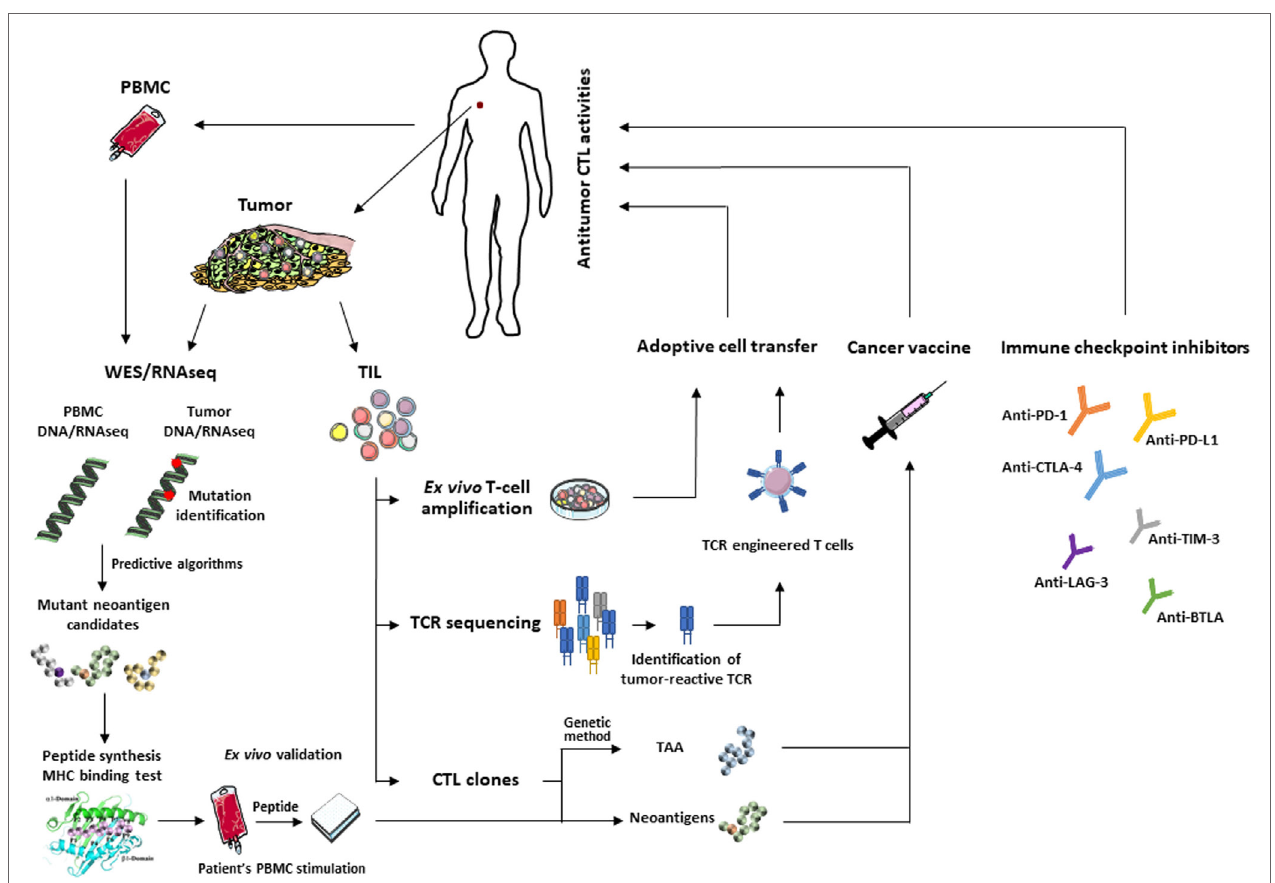
FiGURe 1 | Main approaches for T-cell-based cancer immunotherapy: identification of immunogenic tumor antigens using WES/RNAseq and predictive programs (left) or CTL and genetic approach for the development of effective therapeutic cancer vaccines. Adoptive transfer of selected tumor-infiltrating lymphocytes (TIL) or autologous T cells engineered to express tumor-reactive T-cell receptor (TCR) (middle). These approaches can be combined with immune checkpoint inhibitors (right) to reverse T-cell exhaustion and optimize antitumor T-cell